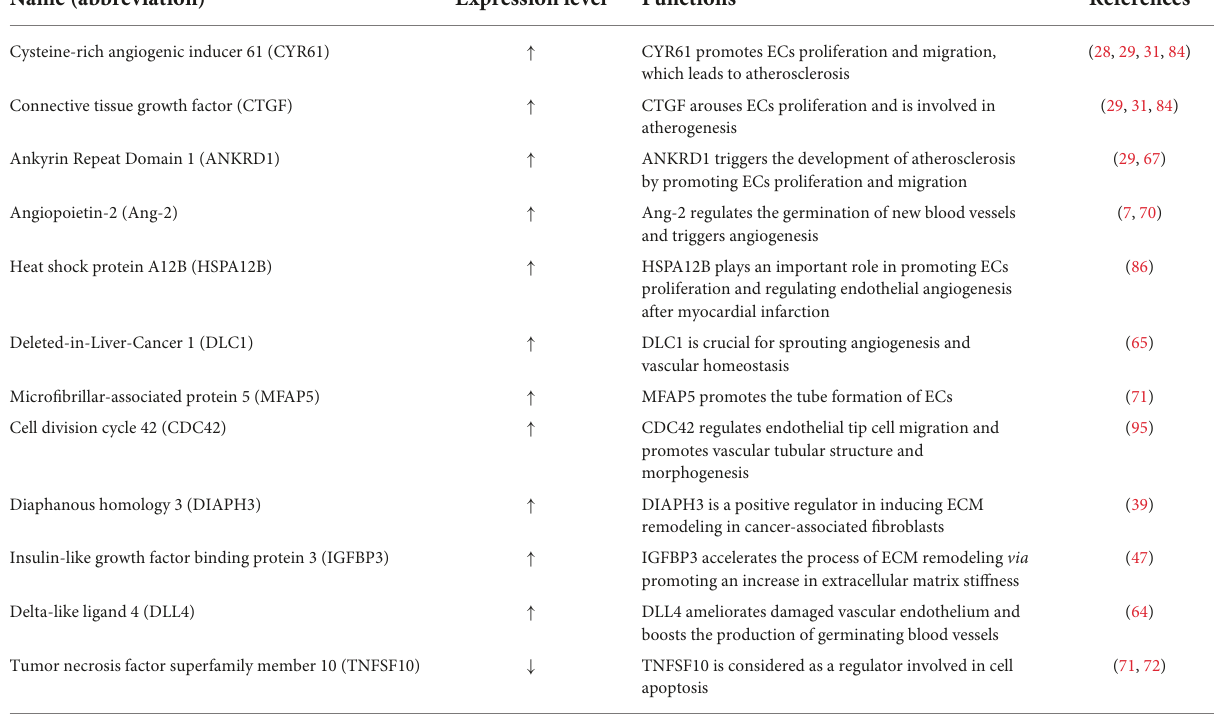
TABLE 1 Related downstream target genes of